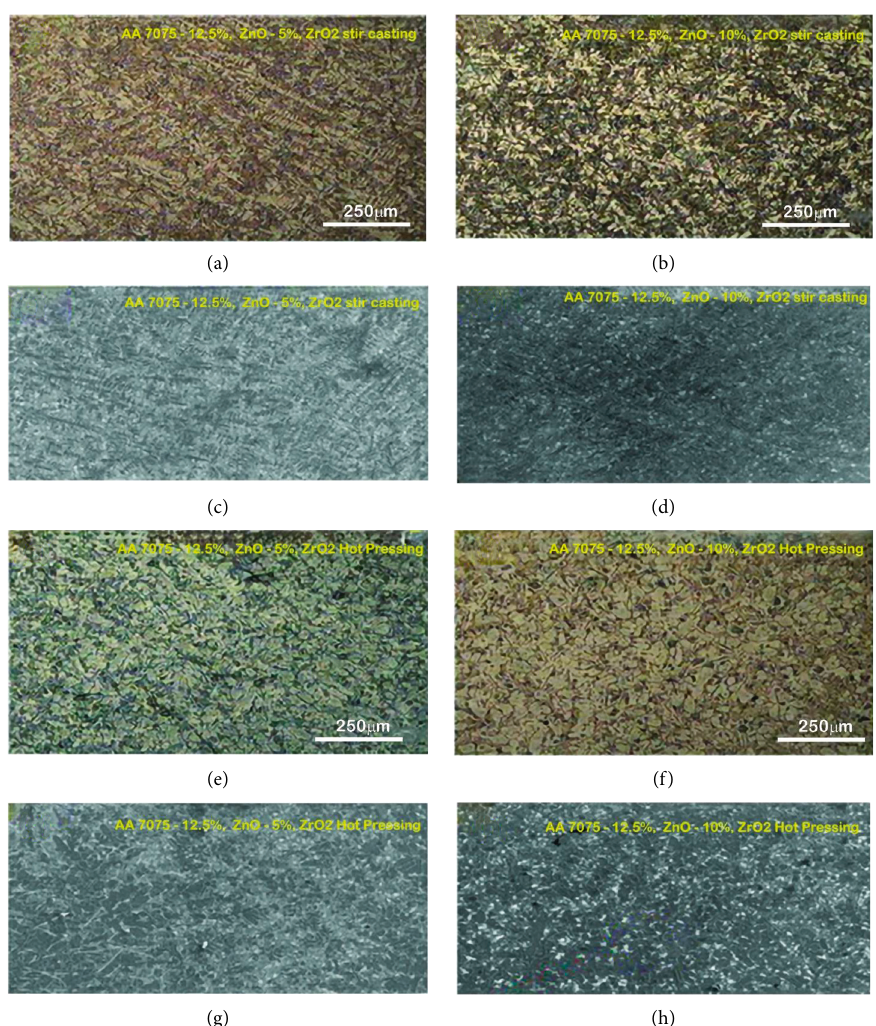
Figure 13: Microstructure of hot-pressed and stir-casting AA 7075/ZnO-ZrO 2 composite. (a, c) AA7075-12.5%, ZnO-5%, ZrO 2 stir casting. (b, d) AA7075-12.5%, ZnO-10%, ZrO 2 stir casting. (e, g) AA7075-12.5%, ZnO-5%, ZrO 2 hot pressing. (f, h) AA7075-12.5%, ZnO-10%, ZrO 2 hot pressing. Table 13: Validation experimental outcome for optimum settings for stir-casting progression. State Processing parameters Response Composite